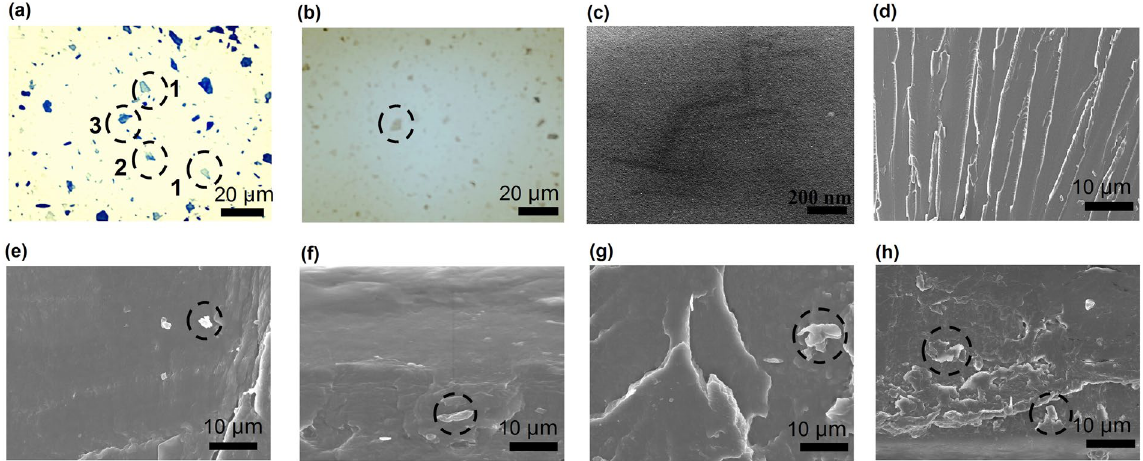
Figure 3. Characterization of composites: the optical micrographs of the liquid epoxy mixtures containing bGO before ( a ) and after ( b ) curing; TEM of bGO/BFDE composite with 0.5% weight content of bGO ( c ); SEM micrographs of bGO/BFDE composite with bGO 0 ( d ), bGO 0.05 ( e ), bGO 0.1 ( f ), bGO 0.3 ( g ), and bGO 0.5 ( h ) weight content of